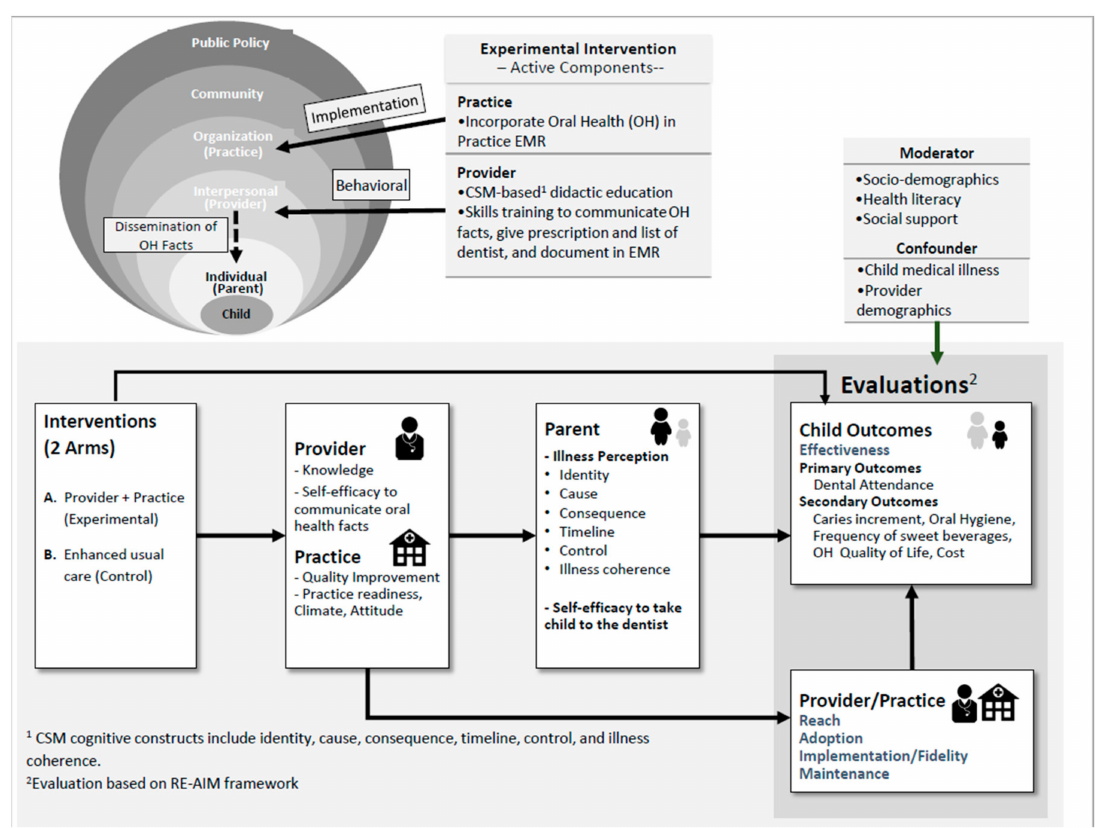
Figure 2. Conceptual model of the main